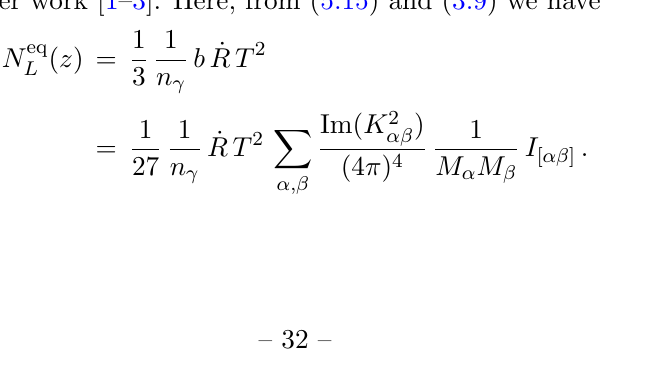
Im( K 2 ) and Im( K 2 ). A reasonable range of values for " 12 13 from neutrino masses, is " (cid:24) 10 (cid:0) 5 {10 (cid:0) 10 1